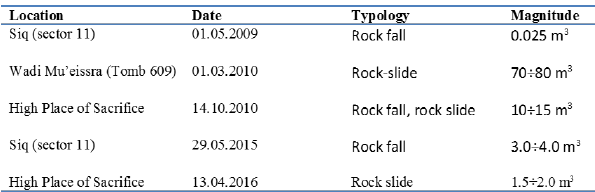
Table 1. Inventory of recent landslide events in Petra.